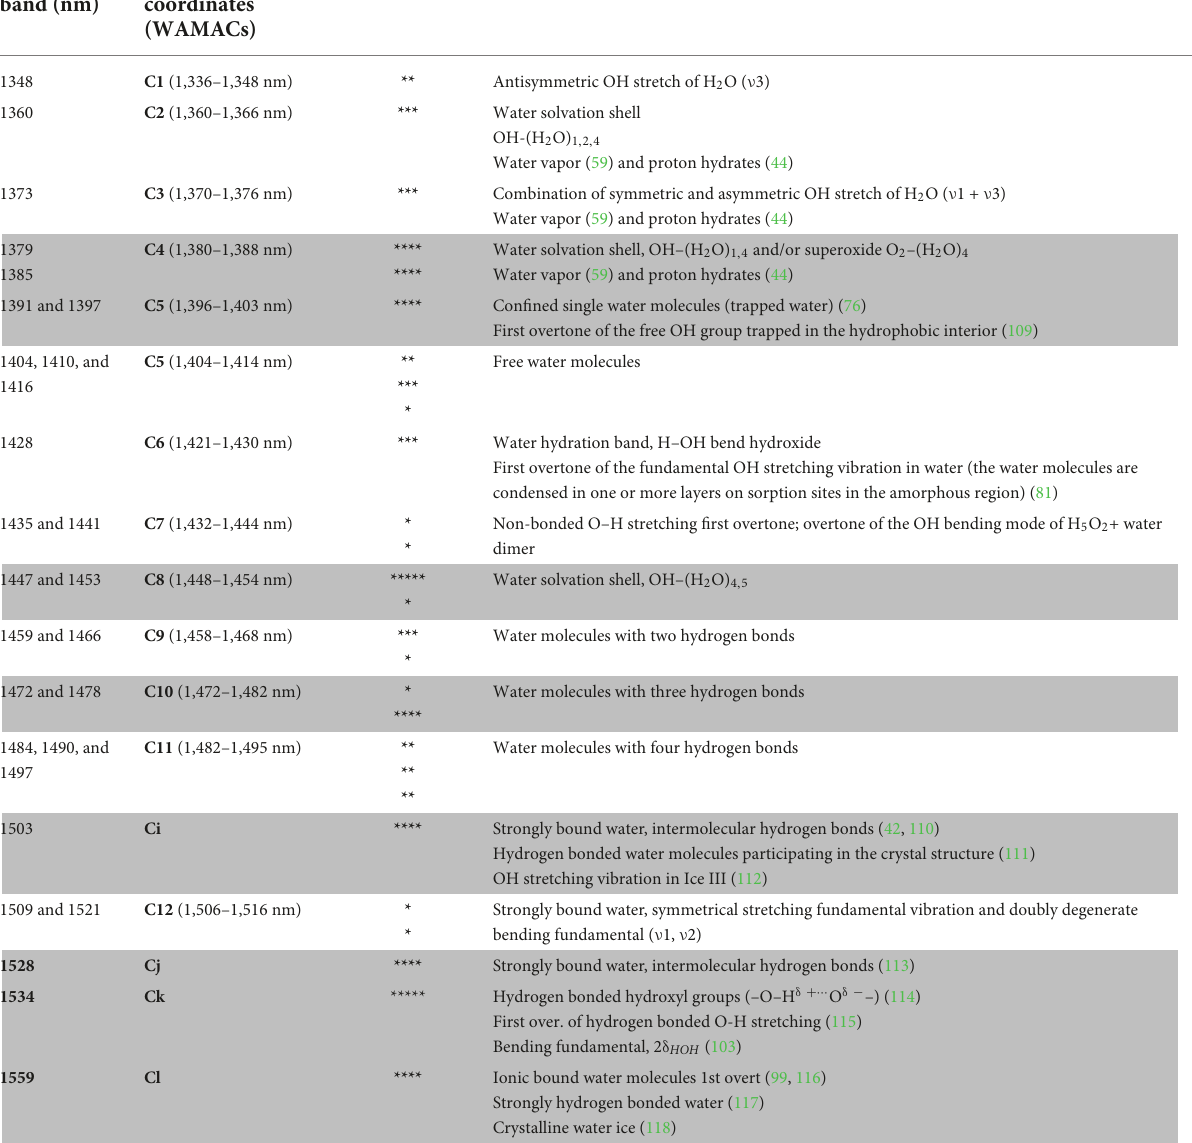
TABLE 1 Water matrix coordinates (WAMACs) that carry information about the changes in strawberry during cold storage [Number of stars “*” in the column Importance represents the number of occurrences of the absorbance band as an influential variable during the whole analysis, as summarized in detail in Supplementary Table 1 . Unless otherwise indicated in the table, the source of all information are references (58, 66)